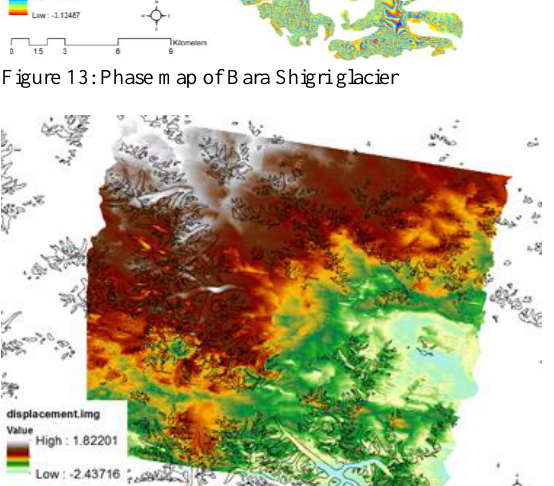
Figure 16: SAR image composite of Siachen glacier (2015).